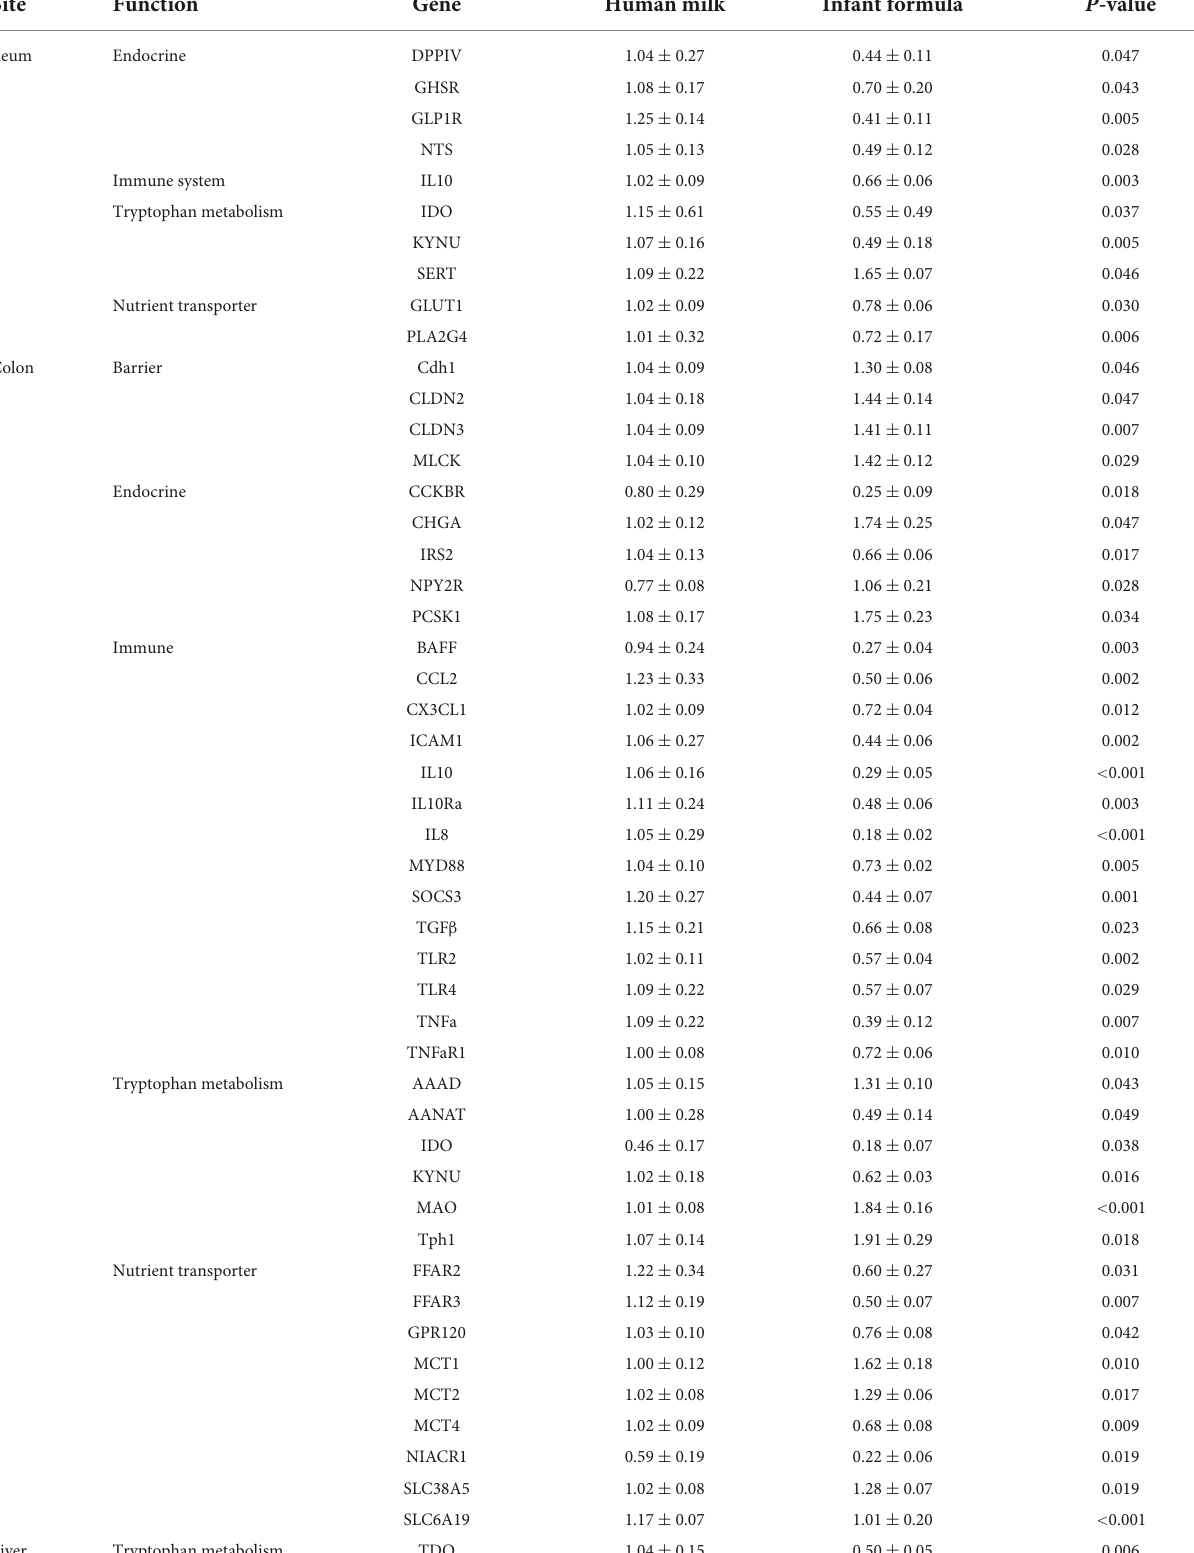
TABLE 5 Relative expression of differentially expressed genes ( p < 0.1) in the ileum and the colon of HM- and IF-fed piglets (mean ± SEM). Site